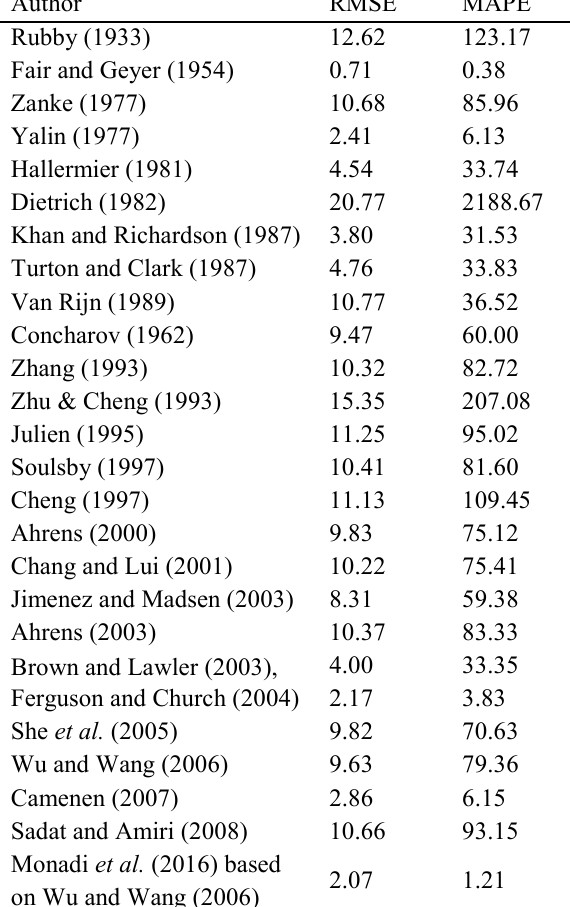
Table 4. Root-Mean-Square and mean absolute percentage errors in numerical model and 26 famous